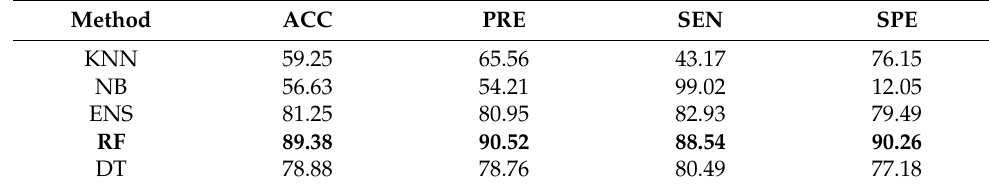
Table A3. AF detection performance based on CTW–RQA features ( n = 3).